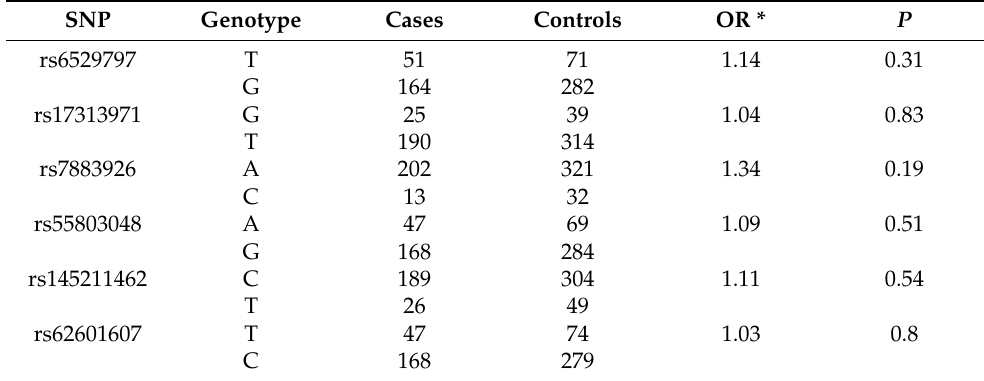
Table 3. Genotype of peak SNPs in females.